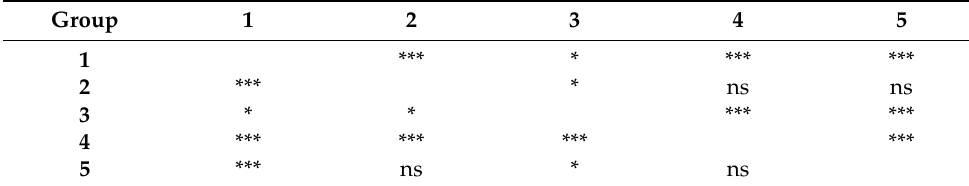
Figure 3. Comparison of the survival curves of the non-irradiated control (black line), standard proton therapy (green line, group 5), pMBRT delivered in one fraction (red line, group 2) or in two fractions (blue line, group 3) both with an average dose of 15 Gy/array, and pMBRT delivered in two fractions of 20 Gy/array (brown line, group 4). The differences were significant for the log-rank (Mantel–Cox) test (Chi square = 52.42, df = 4, p < 0.0001). Table 3. Differences in the survival curves of the different groups. “ns” refers to non-significant, one and three asterisks represent p -values less than 0.05 and 0.001,